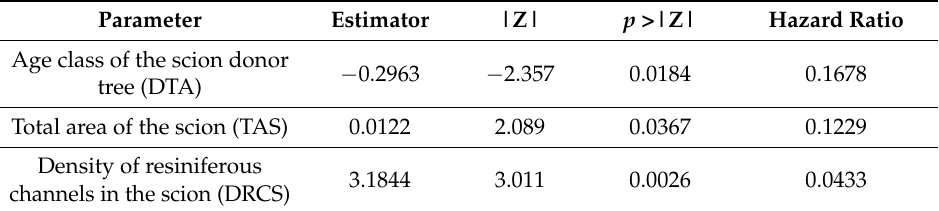
Table 10. Cox proportional hazards model in terms of the risk of death of Pinus engelmannii Carr. grafts. Parameter